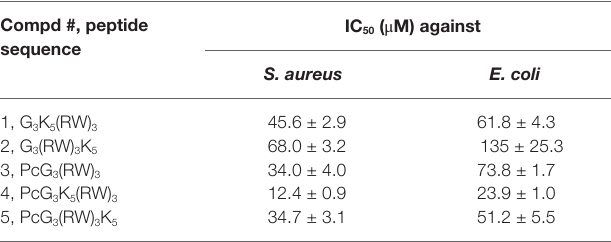
TABLE 1 | Half-maximal inhibitory concentrations (IC 50 s) of antimicrobial peptides against bacteria. Compd #, peptide sequence